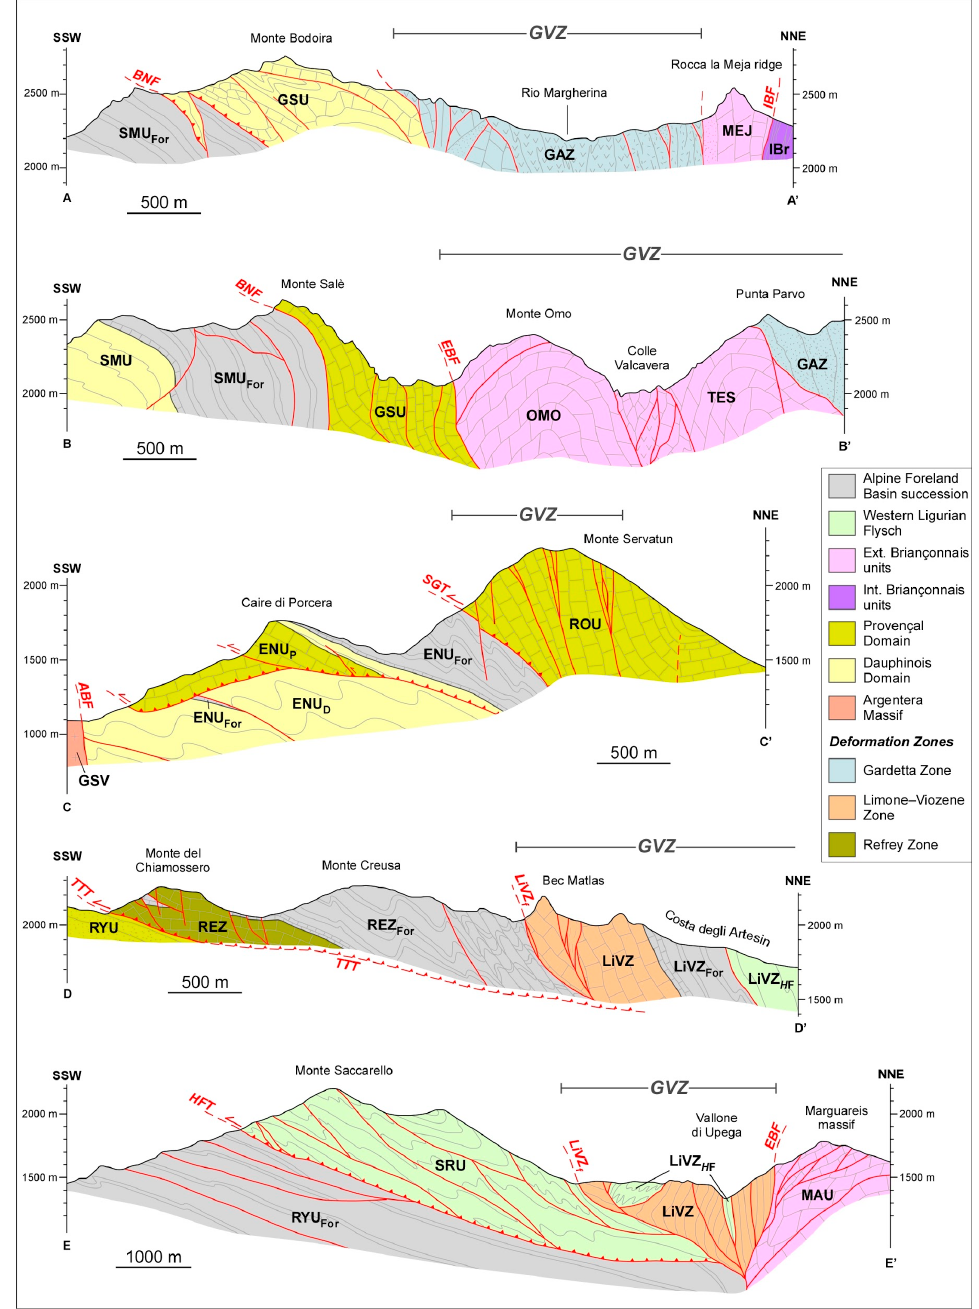
Figure 4. Geological cross-sections across the Gardetta-Viozene Zone (GVZ; location in Figure 3); modified from [20] (sections AA’, BB’); [27] (sections CC’, DD’); [26] (section EE’). Tectonic units: ENUD: Dauphinois succession of Entracque